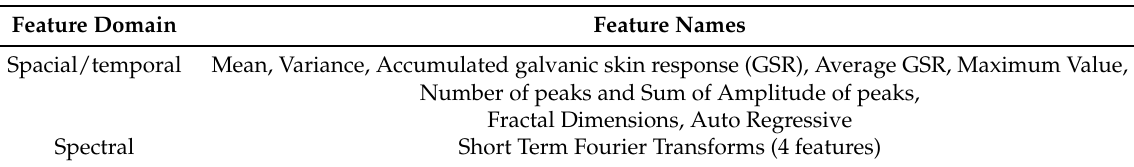
Table 1. List of all the extracted spectral and spacial/temporal